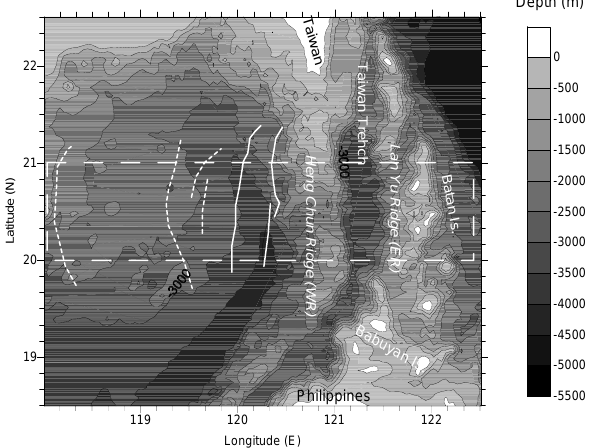
Fig. 1. Model domain showing bottom topography in the Luzon Strait with schematic presentation of generated multiple wave pack- ets (solid lines) and single solitary waves (dotted lines) (Zhao et al.,